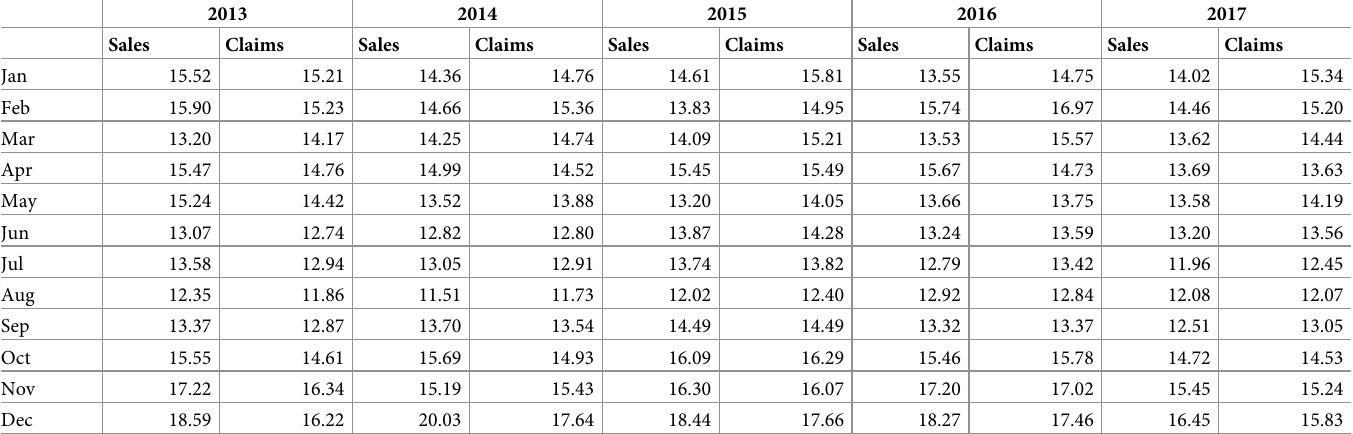
Table 1. Temporal trends in national antimicrobial use according to sales and claims data from 2013 to 2017.